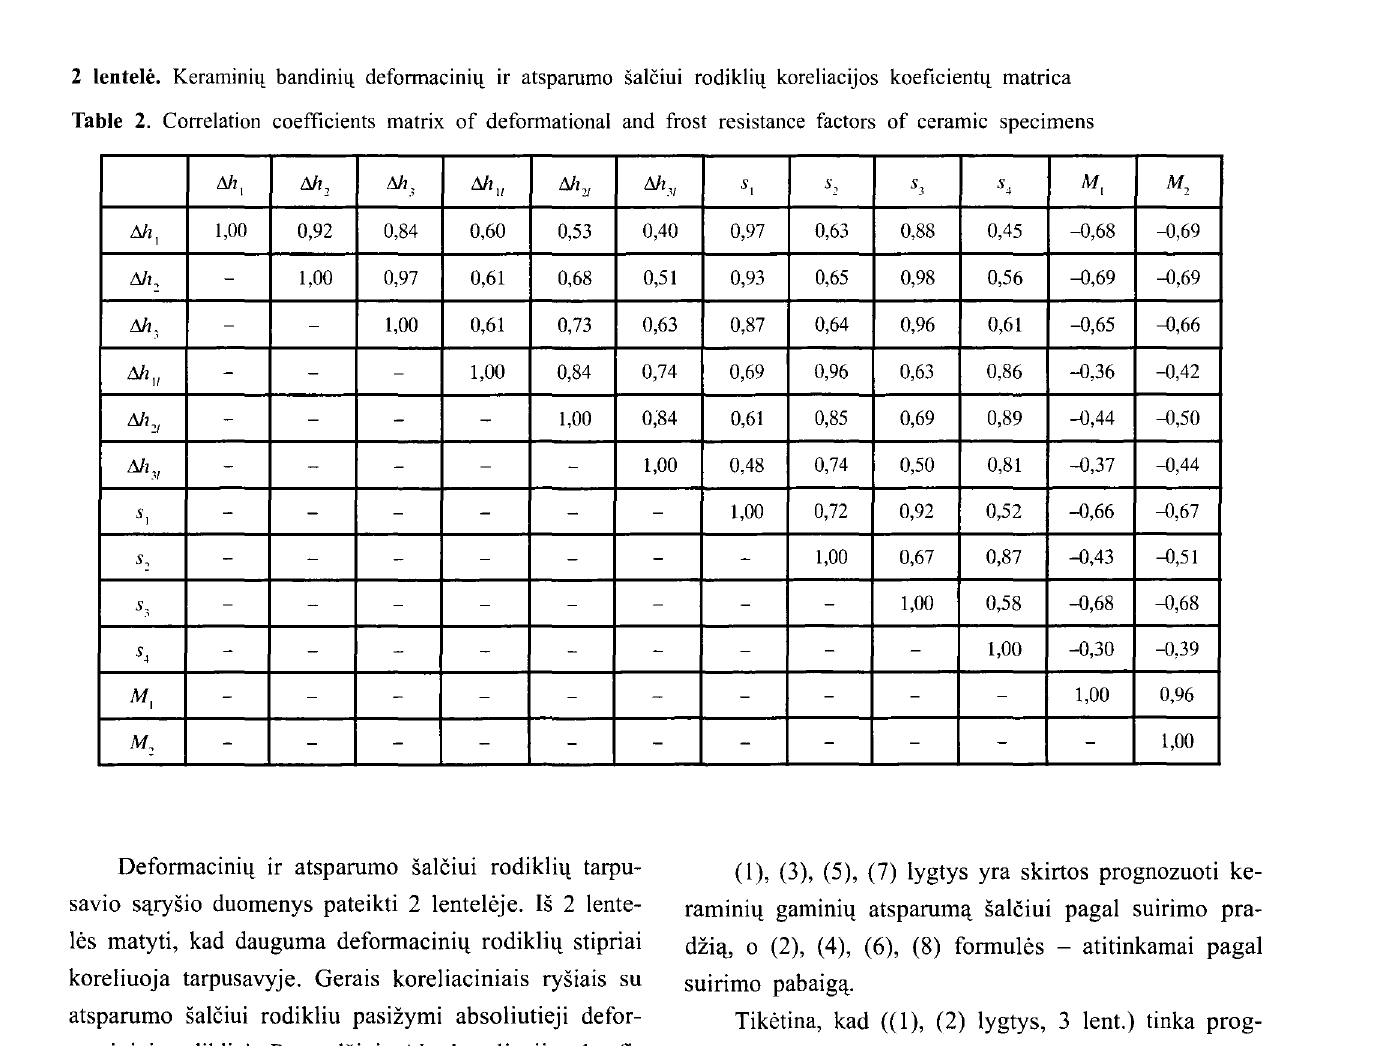
Deformacinill ir atsparumo salCiui rodiklill tarpu savio s(!rysio duomenys pateikti 2 lenteleje. IS 2 lente les matyti, kad dauguma deformacini4 rodiklill stipriai koreliuoja tarpusavyje. Gerais koreliaciniais rysiais su atsparumo salCiui rodikliu pasizymi absoliutieji